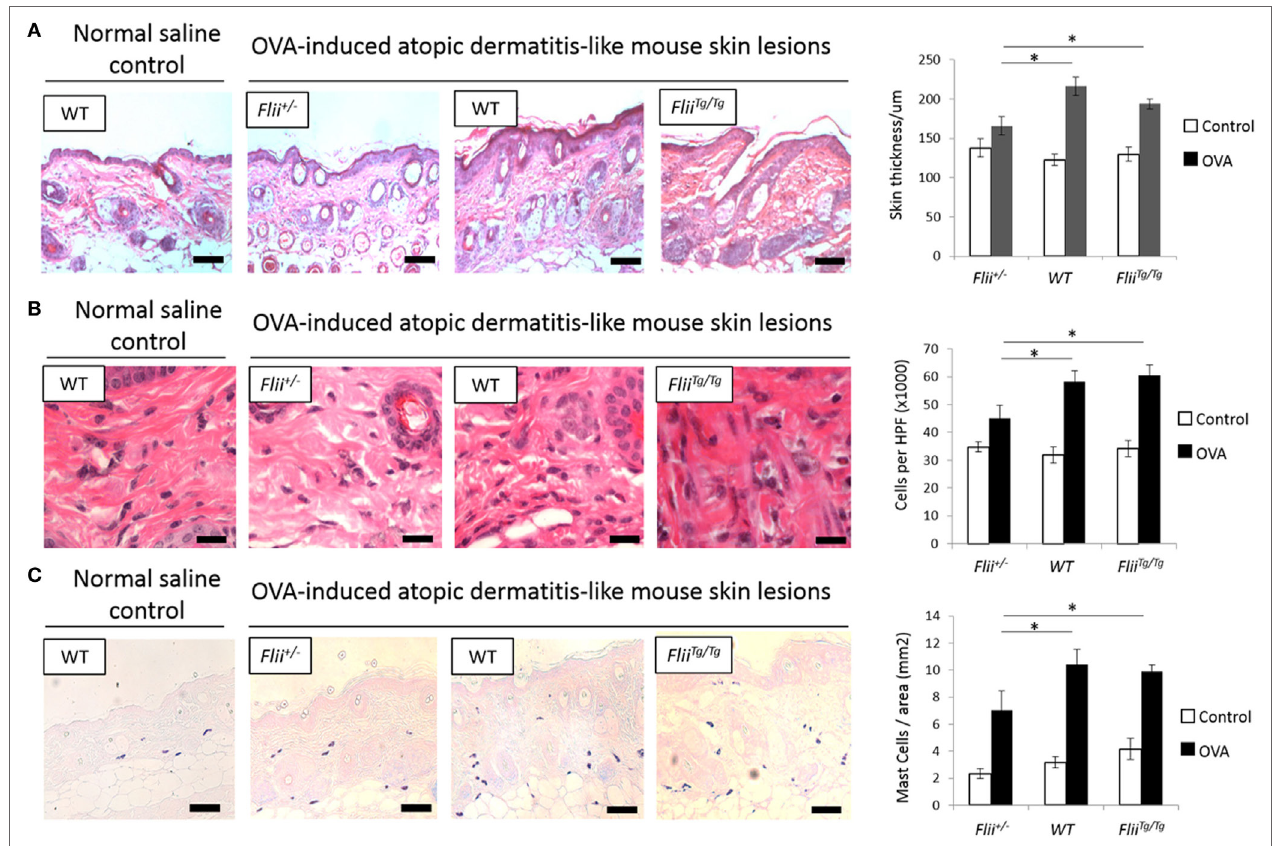
FigUre 2 | Mice with reduced Flii expression develop less severe OVA-induced atopic dermatitis (AD) skin-like lesions and tissue inflammation. (a) Representative images and graphical analysis of skin thickness in Flii + / − , WT, and Flii Tg/Tg mice with OVA-induced AD skin-like lesions illustrating evidence of epidermal hyperplasia, edema, and lymphocytic infiltrate. Magnification 4 × scale bar 200 µm. (B) Representative images and graphical analysis of lymphocytic inflammatory infiltrate in in Flii + / − , WT, and Flii Tg/Tg mice with OVA-induced AD skin-like lesions illustrating decreased inflammation in Flii + / − mice skin. Magnification 1,000 × scale bar 25 µm. (c) Representative images and graphical analysis of mast cells numbers in Flii + / − , WT, and Flii Tg/Tg mice with OVA-induced AD skin-like lesions illustrating decreased inflammation in Flii + / − mice skin. Magnification 4 × scale bar 200 µm. n = 8. Mean ± SEM. * <